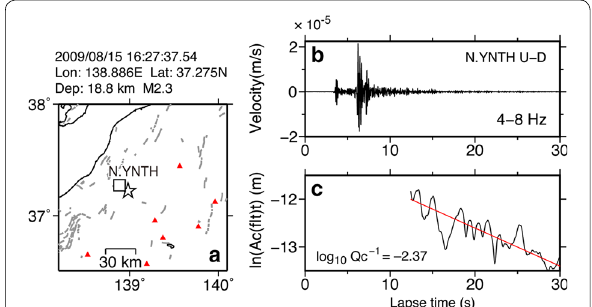
Fig. 2 An example of the estimation of coda Q . a Locations of an epicenter (star) and a station (square). b Seismic velocity waveforms recorded at the station N.YNTH. c Fitting of the single back scattering model (red line) to RMS amplitudes (black